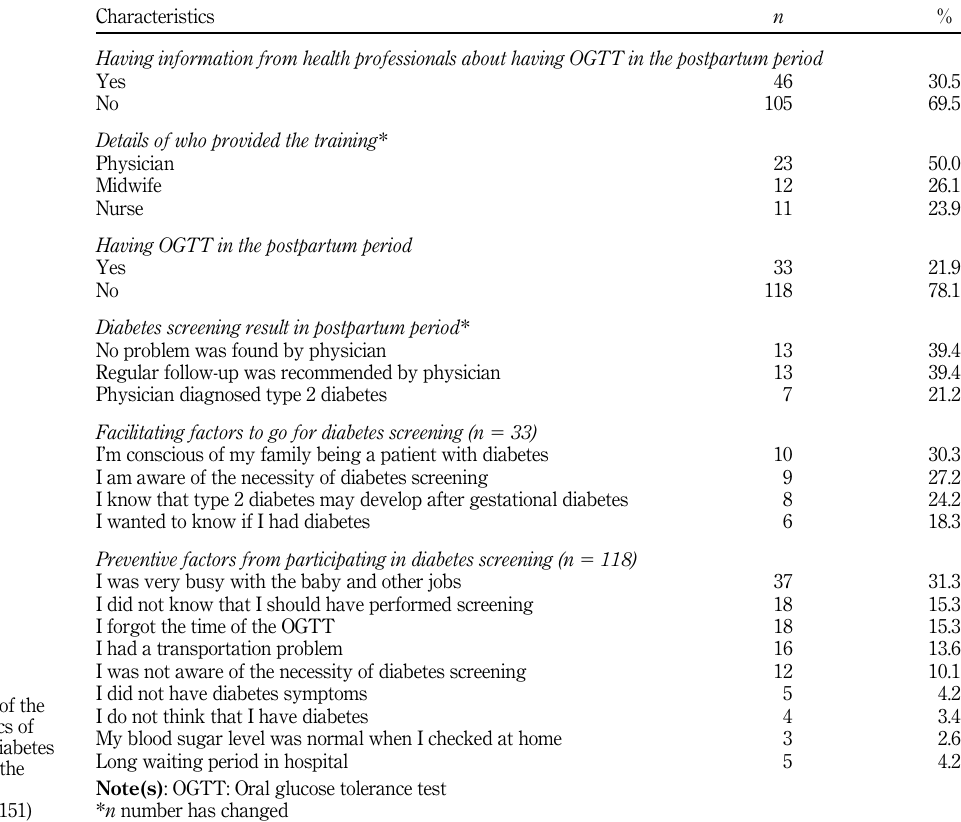
Table 2. Distribution of the characteristics of women for diabetes screening in the postpartum period ( N 5